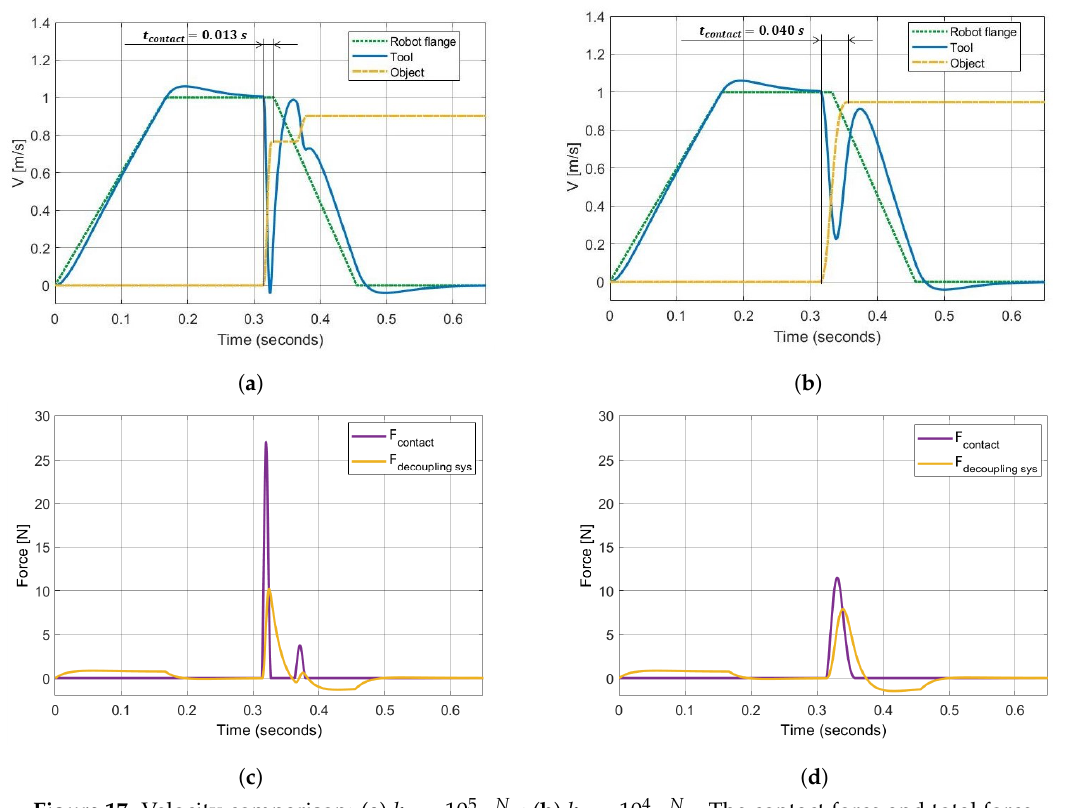
; ( b ) k c = 10 4 N . The contact force and total force m 1.5 m 1.5 ; ( d ) k c = 10 4 N . e = m 1.5 m 1.5